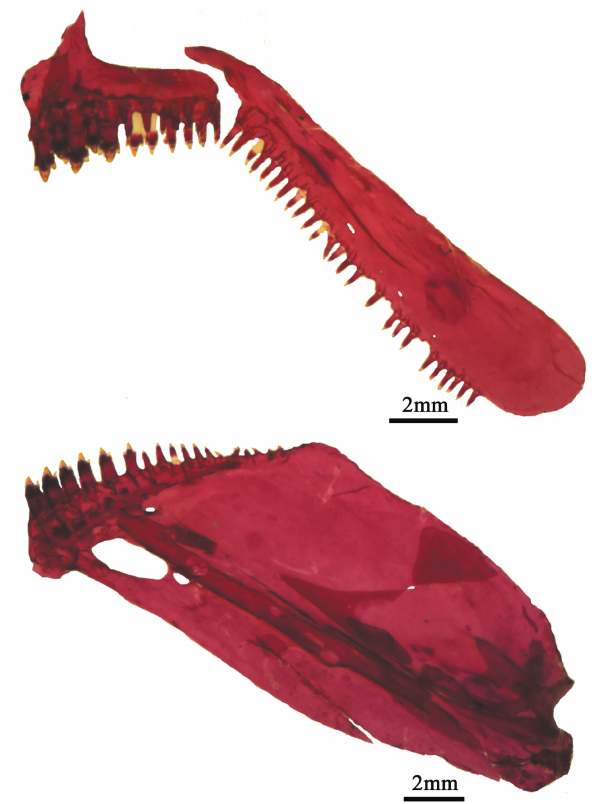
Fig. 3. Phenacogaster julliae , MCP 53629, 24.7 mm SL, paratype: maxilla (top right), premaxilla (top left), and lower jaw (bottom). Lateral view, left side.